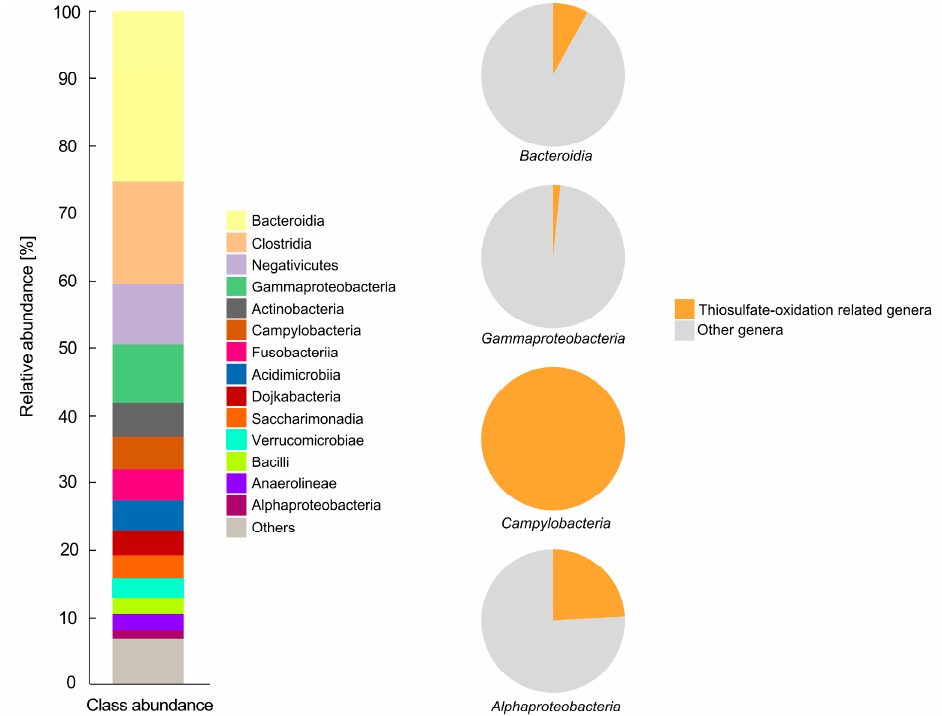
Figure 2. Relative abundance of bacterial classes in the consortium. The abundance at class level was presented in a bar plot. The pie plot shows the proportion of sulfide-oxidizing bacterial (SOB) genera that harbors thiosulfate-oxidation related genes in a specific class (Bacteroidia, Gammaproteobacteria, Campylobacteria, and Alphaproteobacteria, respectively) in which thiosulfate-oxidation related genes, soxA , soxB , soxC , soxX , soxY , soxZ , sqr , and doxD , were identified.